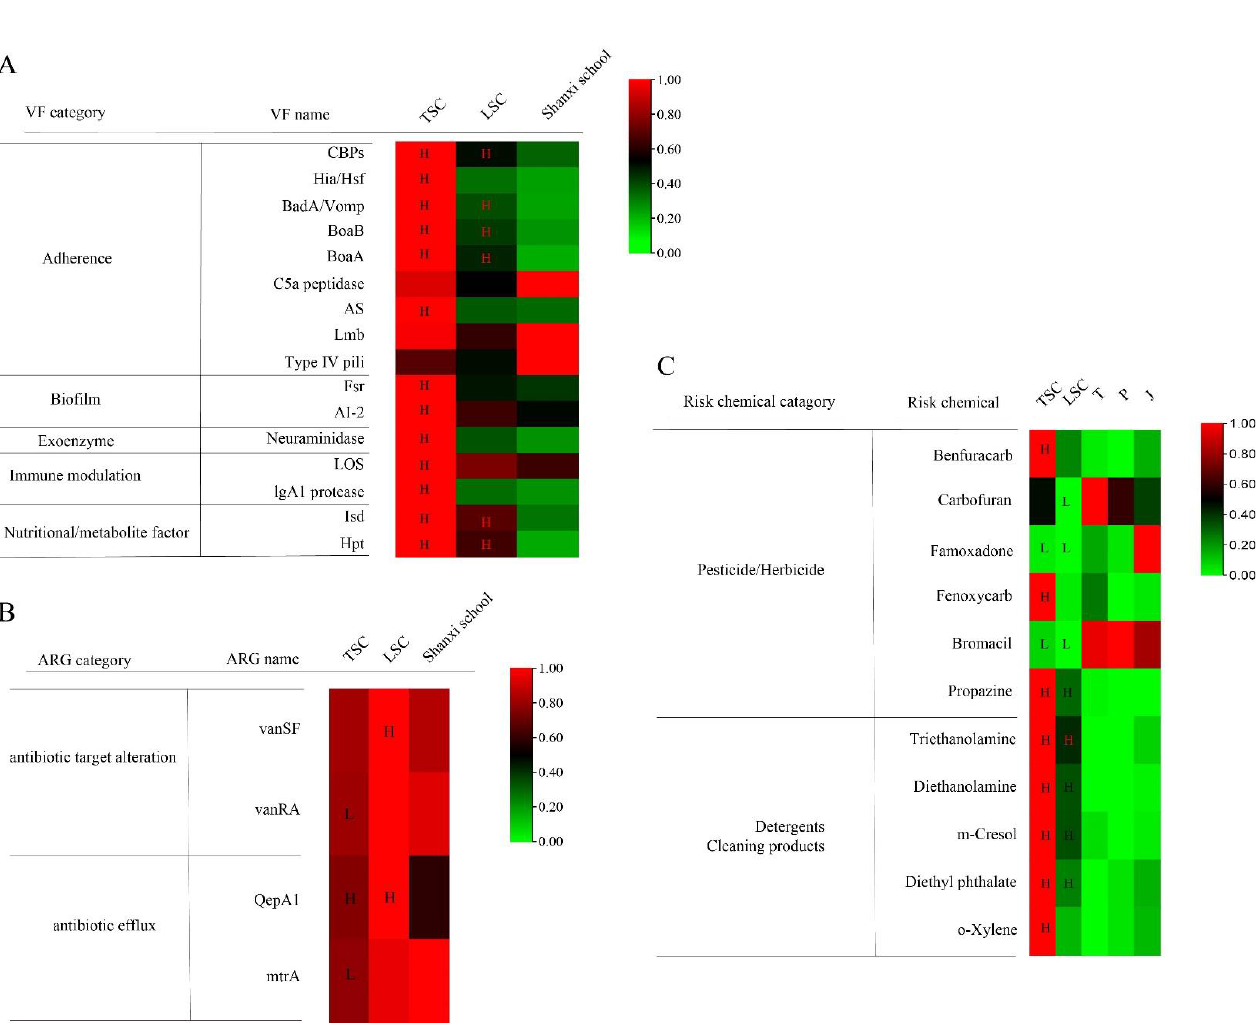
Figure 5. Comparison of relative abundances of ( A ) virulent factors (VFs), ( B ) antibiotic resistance genes (ARGs), and ( C ) synthetic chemicals in aircraft cabins and school classrooms. The most abundant VF, ARG, and chemical in each line is defined as 1. The abundances of VFs, ARGs, and chemicals in TSC and LSC were compared with the schools in Shanxi, China (N = 33); and Terengganu (T), Penang (P), and Johor Bahru (J), Malaysia (N = 96). Significantly higher abundance in TSC/LSC compared to schools is indicated by an “ H ” symbol in the heatmaps, while significantly lower abun- dance in TSC/LSC is indicated by an “ L ” symbol (t-test, p < 0.01). For the four enriched ARGs, vanSF, and QepA1 were found to have a higher abun- dance in the aircraft, compared to schools, while the other two (vanRA and mtrA) had lower abundances in TSC compared to schools ( p < 0.01; Figure 5B). Overall, the abun- dance of ARGs was similar between aircraft and schools.